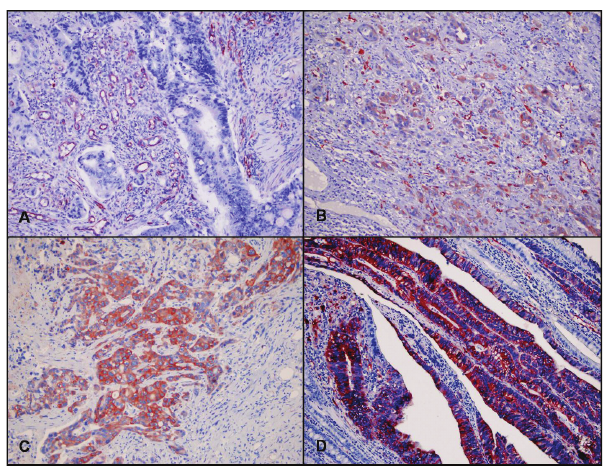
Figure 1 - Negative control (A), weak (B), moderate (C) and strong (D)